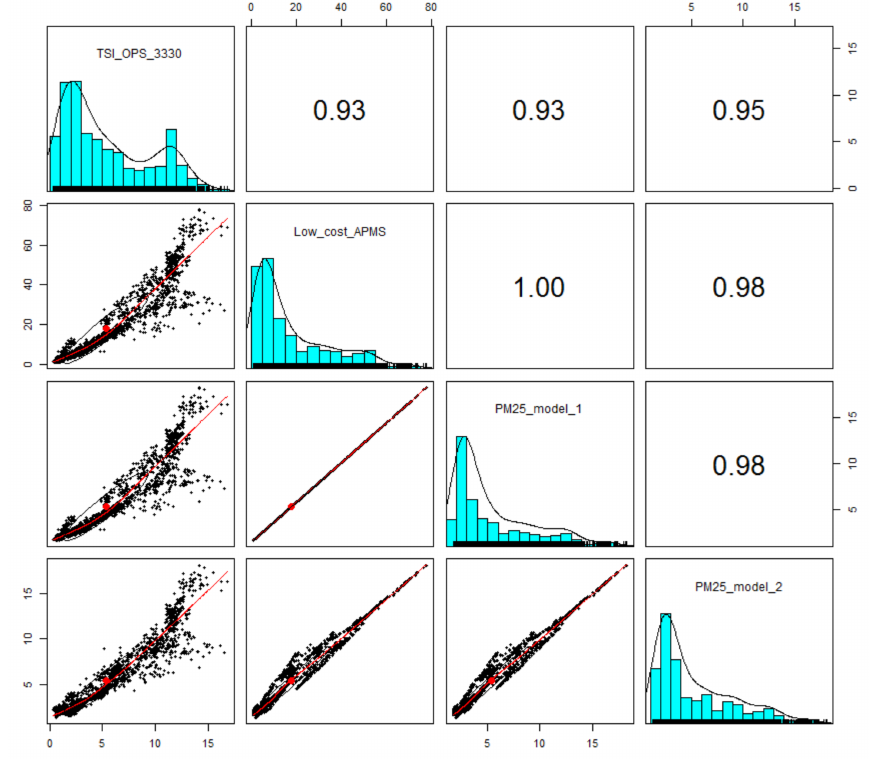
Figure 8. Pairs plot of comparisons between the TSI OPS 3330 measurements, low-cost sensor readings and the output of the derived regression models from the roadside stationary experiment performed from March 6 to March 8, 2017. Upper right section depicts the R 2 as computed by the Pearson method, while lower-left set of panels present pairwise plots of 1 min averages with loess smoothers applied. It is noted that the plots in the same row have the same scale in the y axis (in µ g/m 3 ), while the plots in the same column have the same scale in the x axis (in µ g/m 3